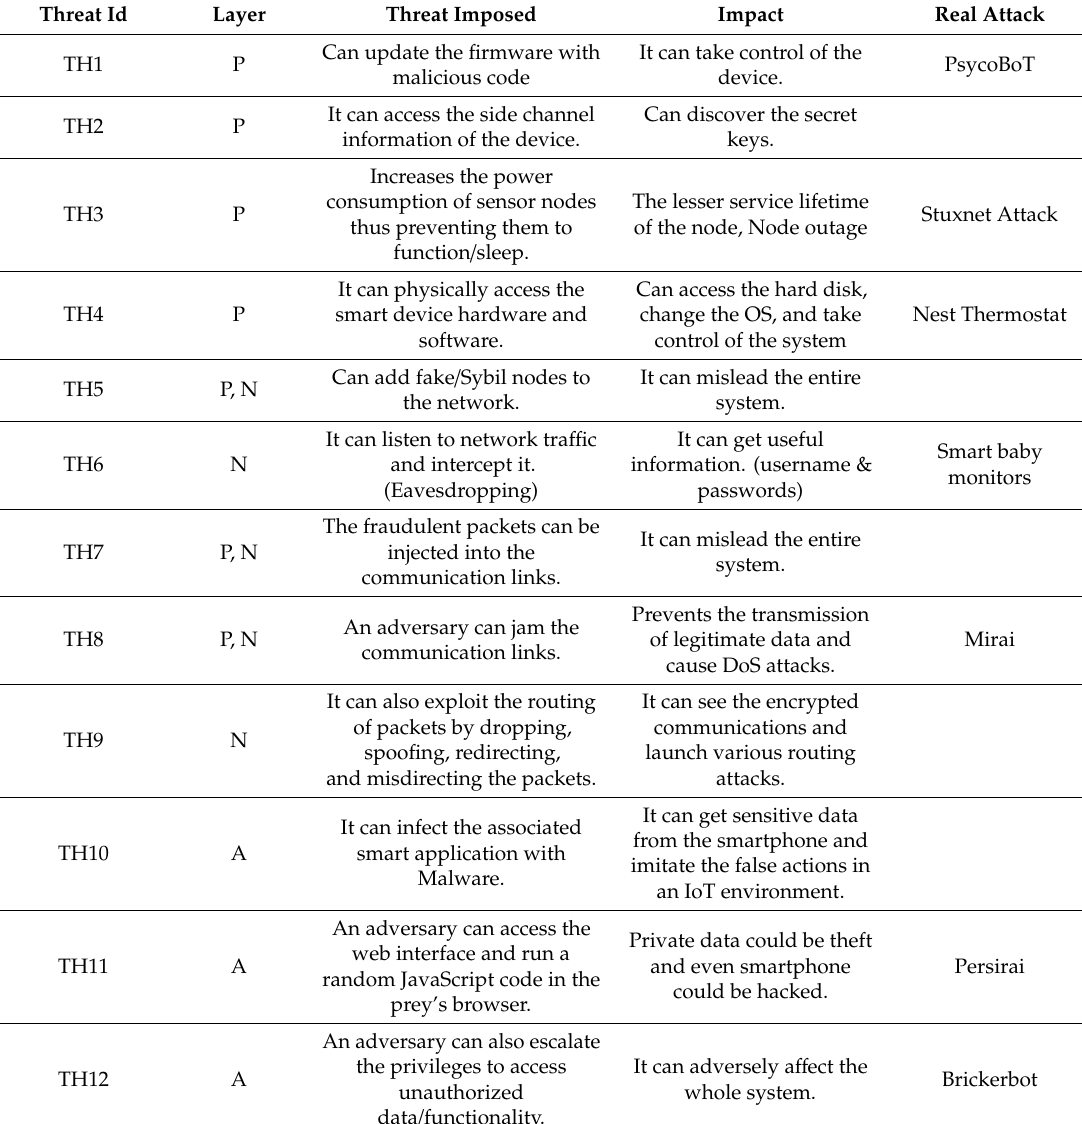
Table 2. Threats and their